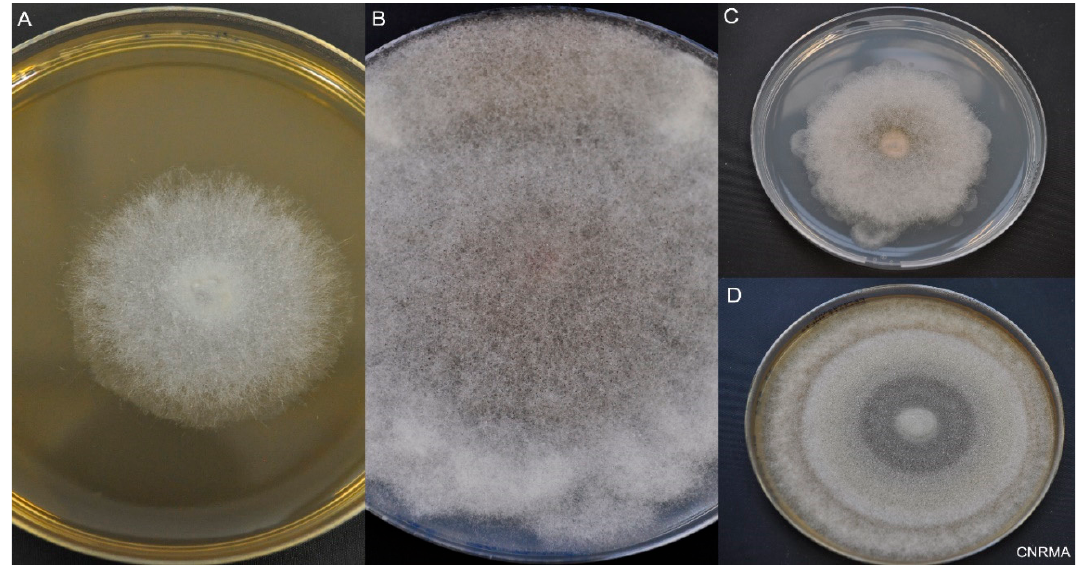
Figure 3. Macroscopic aspect of Mucorales. Incubation at 30 °C on 2% malt extract (MEA) or potato dextrose agar (PDA). ( A ) Lichtheimia ramosa on MEA at day 2. ( B ) Rhizopus microsporus on PDA at day 6. ( C ) Lichtheimia corymbifera on PDA at day 6. ( D ) Mucor velutinosus on PDA at day 6.